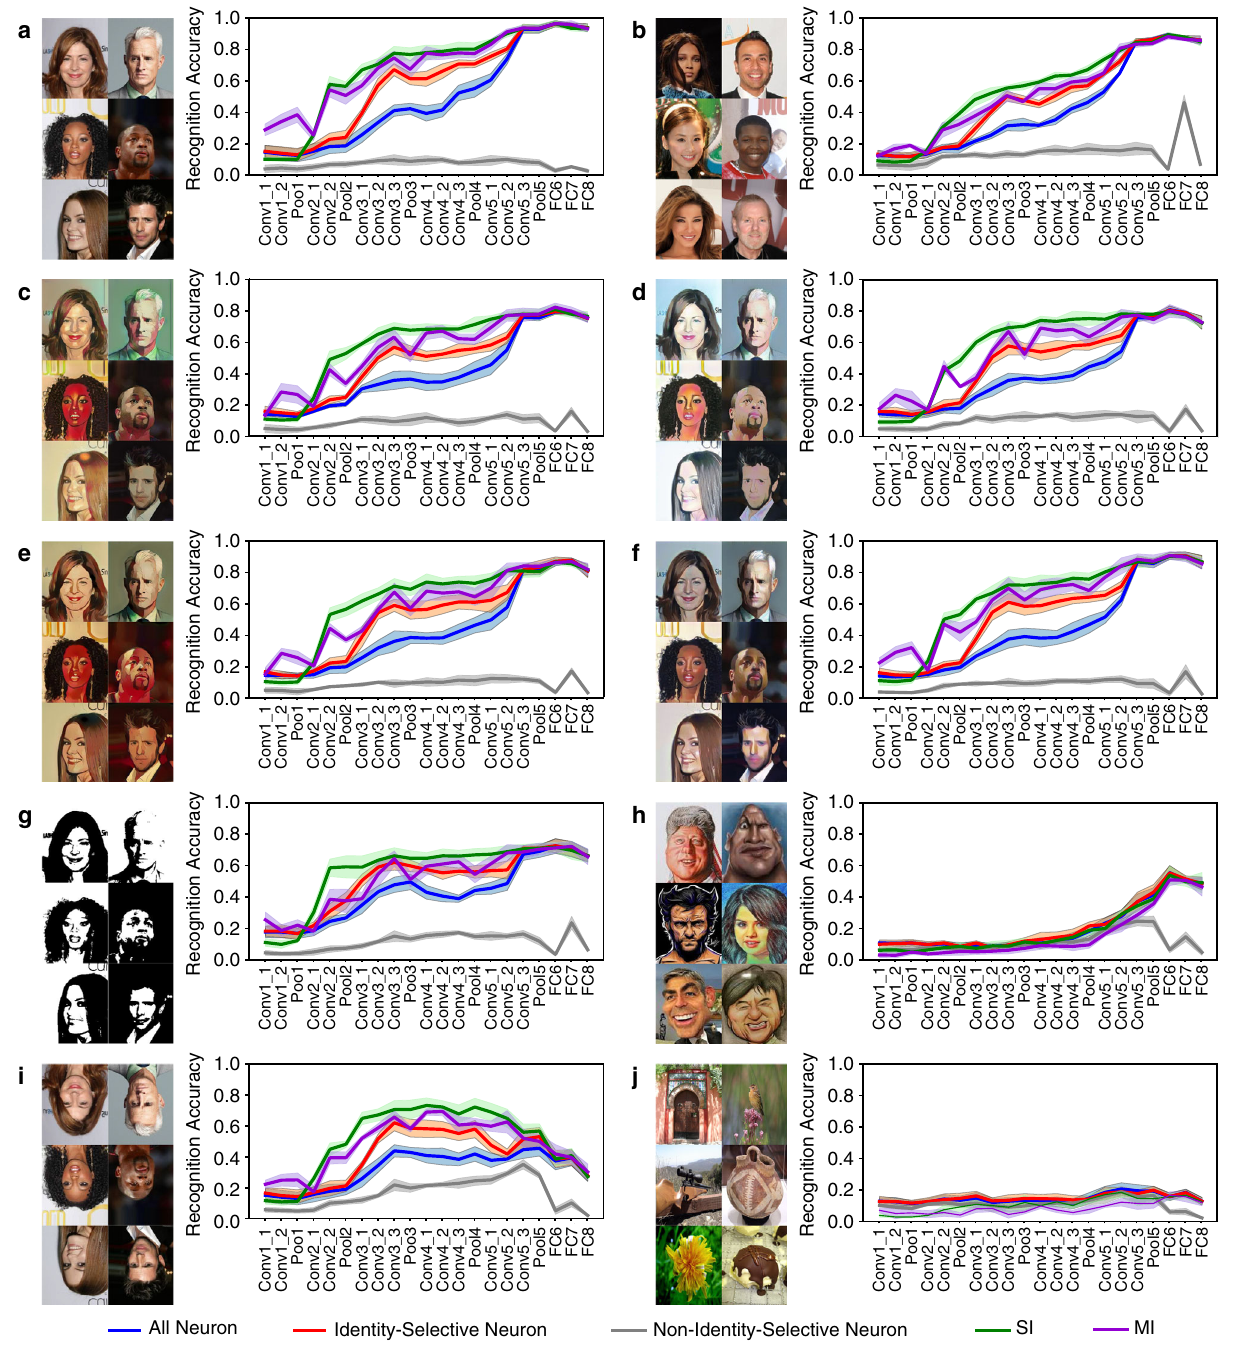
Fig. 2 Selectivity properties of identity-selective units. a Original faces used to identify identity-selective units. b Faces from a different set of 50 identities randomly selected from the CelebA database. c Original faces in the cartoon style Hayao. d Original faces in the cartoon style Hosoda. e Original faces in the cartoon style Paprika. f Original faces in the cartoon style Shinkai. g Original faces in the Mooney style. h A different set of celebrity caricature faces. i Original faces in inversion. j A set of non-face objects selected from the ImageNet stimuli. Identity recognition accuracy is shown for each deep neural network (DNN) layer. Error shade denotes one standard deviation across fi ve-fold cross-validation. Blue: all units from each DNN layer. Red: identity-selective units. Gray: non-identity-selective units. Green: single-identity (SI) unit. Purple: multiple-identity (MI)